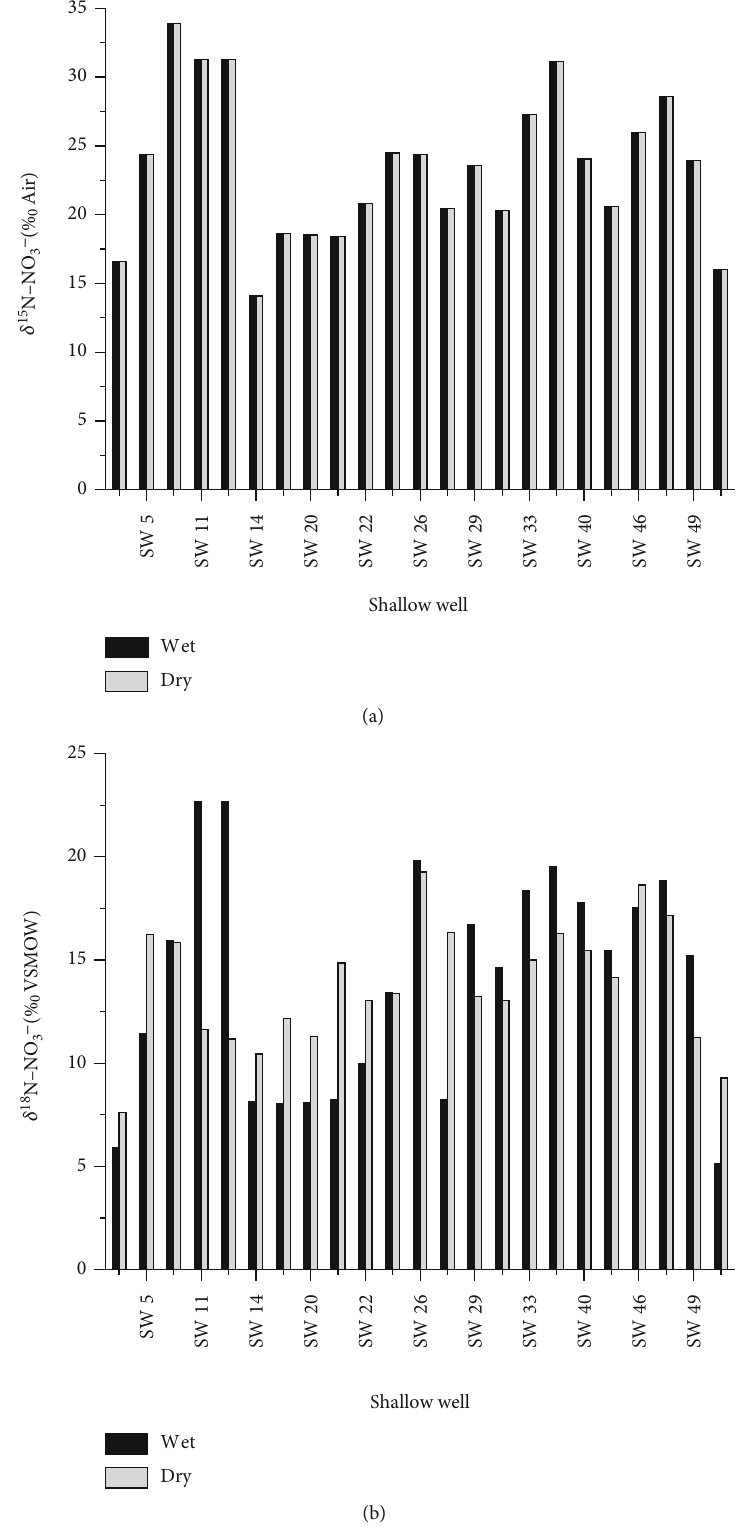
− and (b) δ 18 O-NO 3